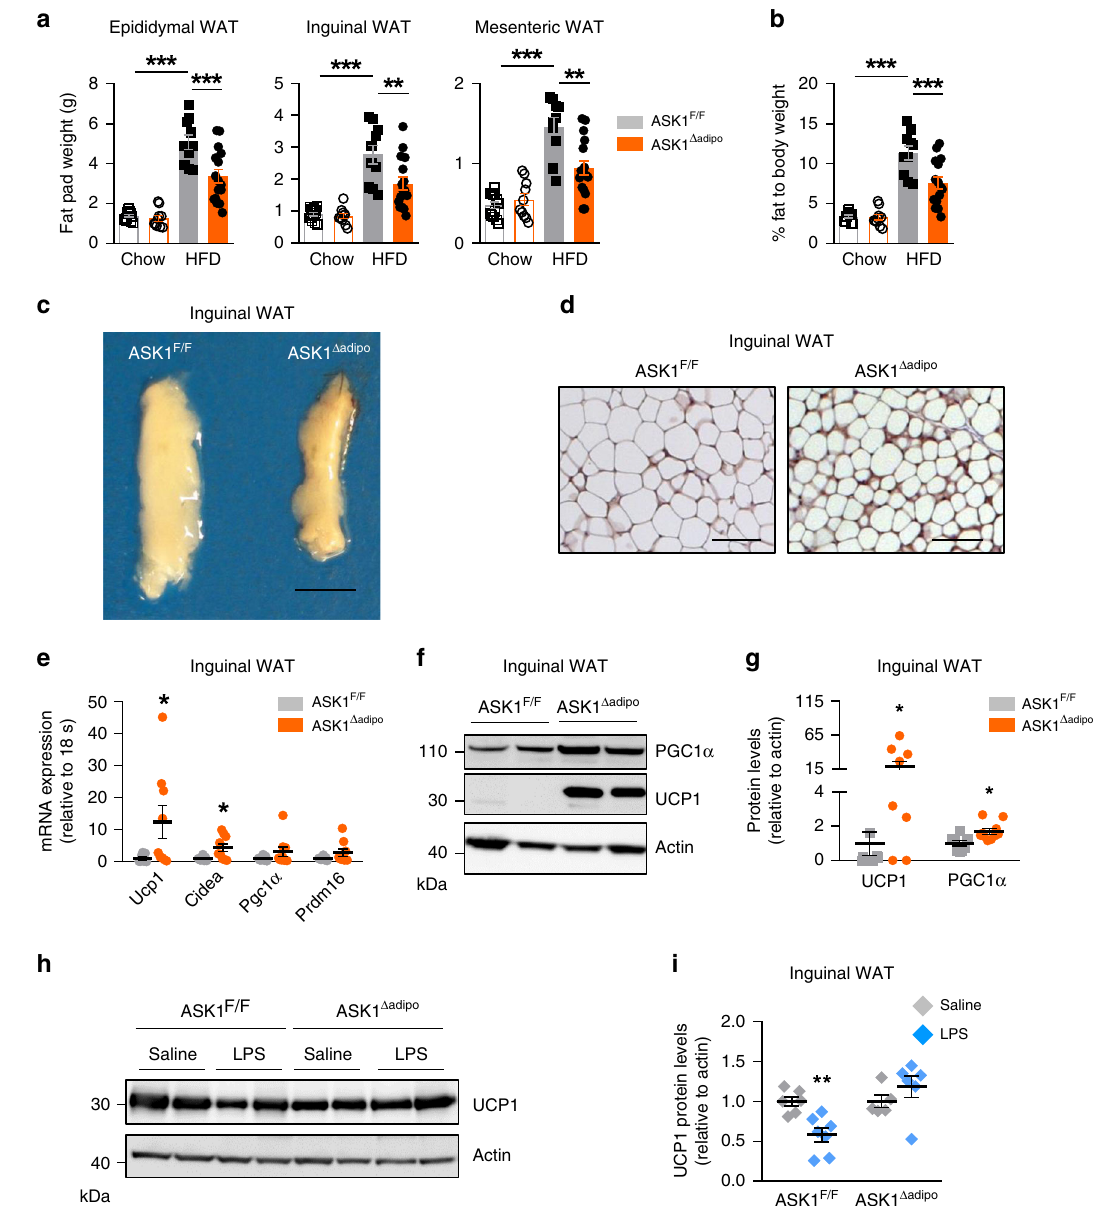
Fig. 4 Increased adipose tissue browning in HFD-fed ASK1 Δ adipo mice. a , b Fat pad mass as well as total body fat mass (chow-fed: ASK1 F/F , n =